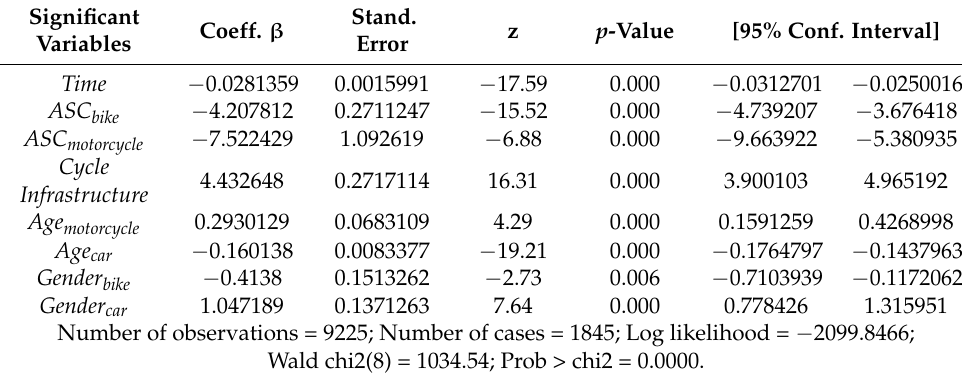
Table 4. Calibration results [30].